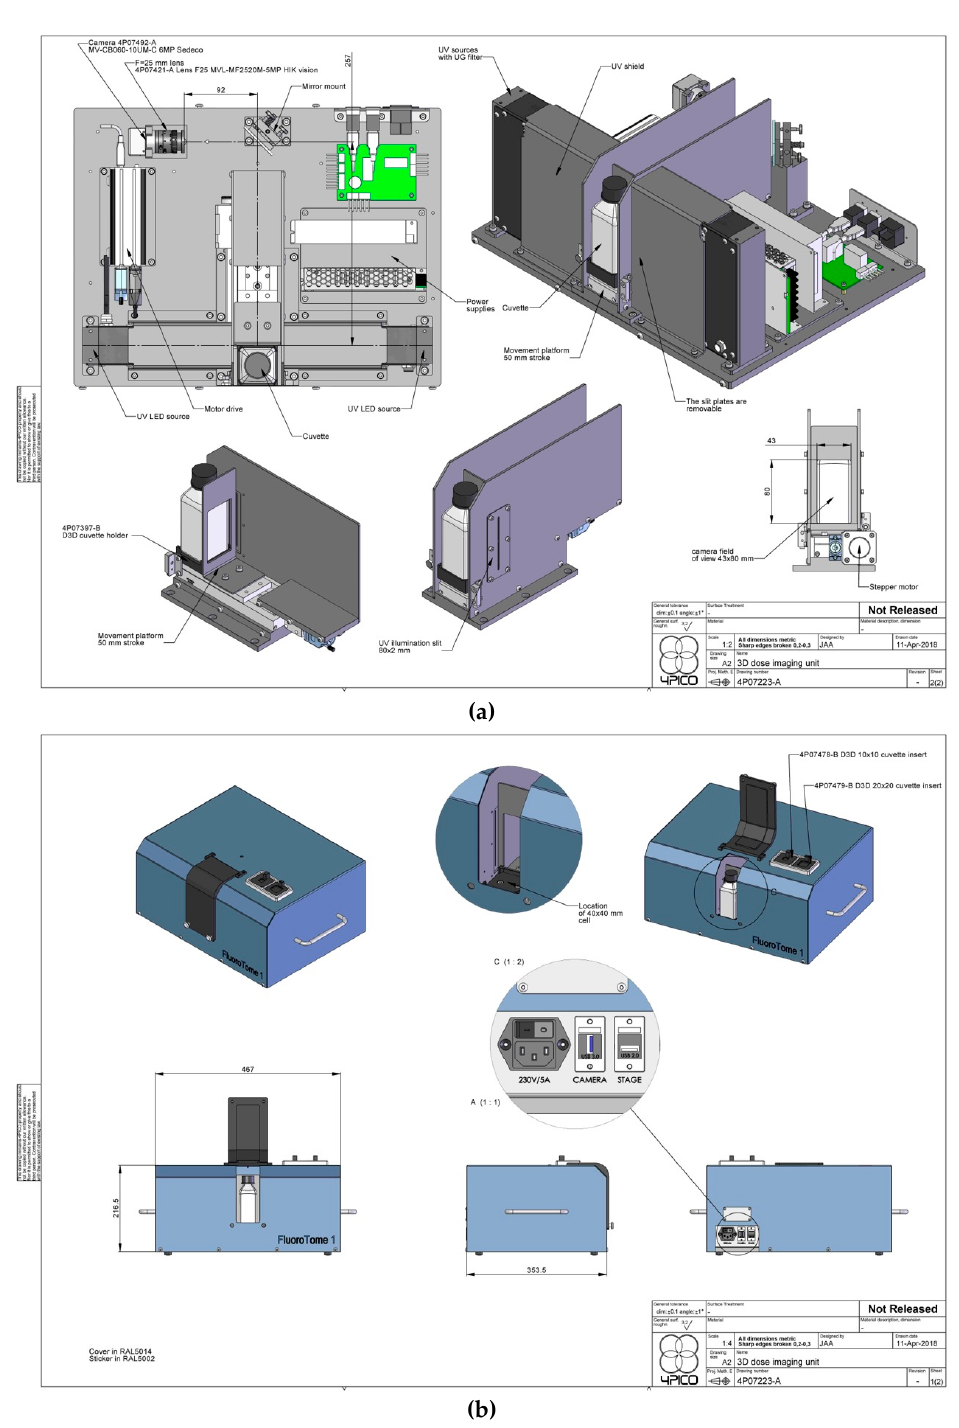
Figure 4. a (upper) and b (lower) are schematic drawings of the internal and external details of the Figure 4. ( a ) ( upper ) and ( b ) ( lower ) are schematic drawings of the internal and external details of the apparatus respectively. See supplemental information for downloadable .jpg files. apparatus respectively. See supplemental information for downloadable .jpg